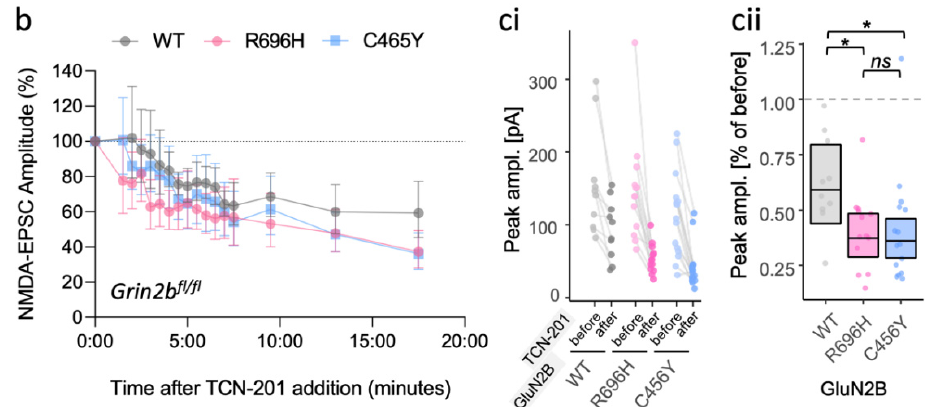
Figure 3. Gain- and loss-of-function GluN2B mutants both increase inhibition of NMDA-EPSCs in GluN2B knockout neurons by the GluN2A-selective antagonist TCN-201. ( a ) Representative pharmacologically isolated NMDA-EPSCs (average of 20 sweeps) from transfected CA1 neurons before and 17.5 min after application of 10 µM TCN-201. ( b ) NMDA-EPSC +20 mV peak amplitudes expressed as a % of the initial EPSC size (before application of 10 µM TCN-201) and summarised for all time points as the geometric mean and 95% confidence intervals. ( ci ) NMDA-EPSC peak amplitudes before and 17.5 min after the addition of 10 µM TCN-201; each point represents the peak of the ensemble mean of 20 NMDA-EPSCs, each pair of points connected by a line corresponds to measurements made from individual neurons before and after addition of TCN-201; ( cii ) response ratios (transfected/untransfected) calculated from ( ci ) are expressed as a percentage and plotted for each pair of before–after recordings. Crossbars show the estimated marginal means with 95% confidence intervals backtransformed from the linear mixed models (Figure S1.8). Standardised effect sizes ( r ) for each mutant compared to WT were − 0.37 and − 0.40 for mutants R696H and C456Y, respectively (N = 38). ns = not significant (at α = 0.05), * = p < 0.05.